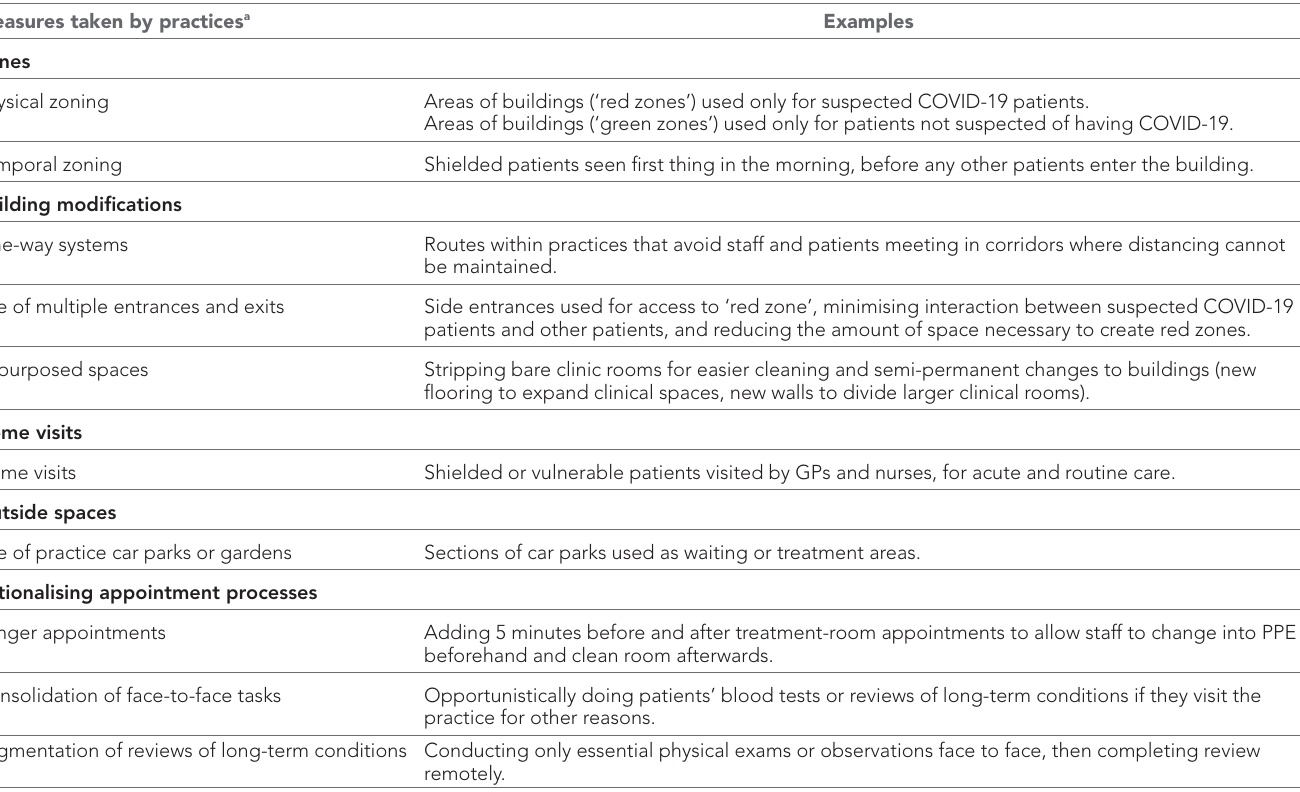
Table 2 Measures taken by practices to make face- to- face contact possible Measures taken by practices